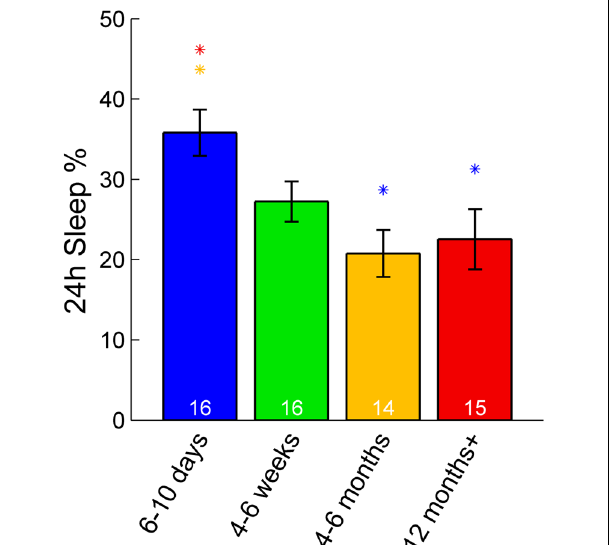
[ F (3,57) = 5.05, p < 0.01], i.e., the 12 + month old group showed